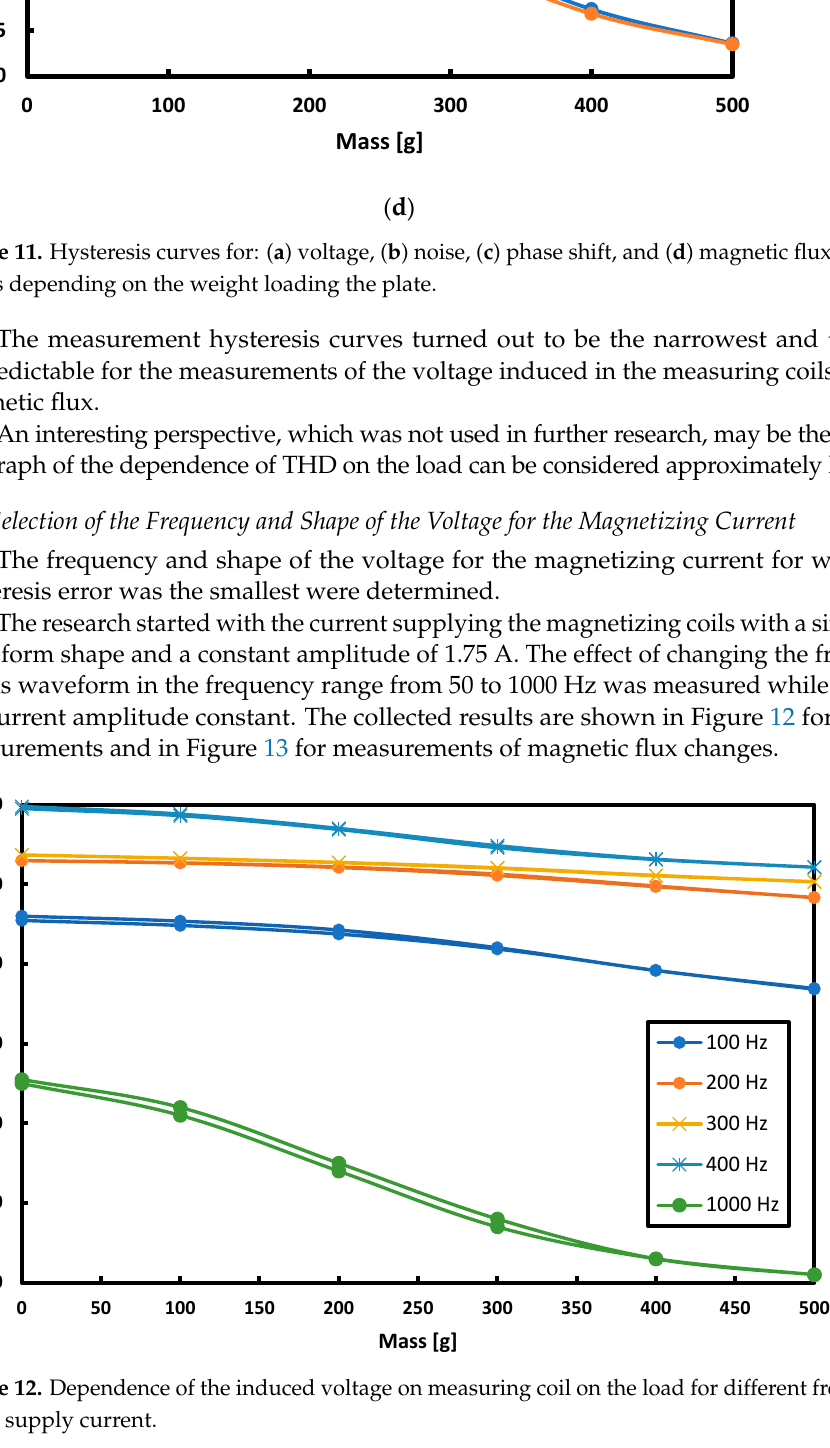
Figure 12. Dependence of the induced voltage on measuring coil on the load for different frequencies of the supply current.